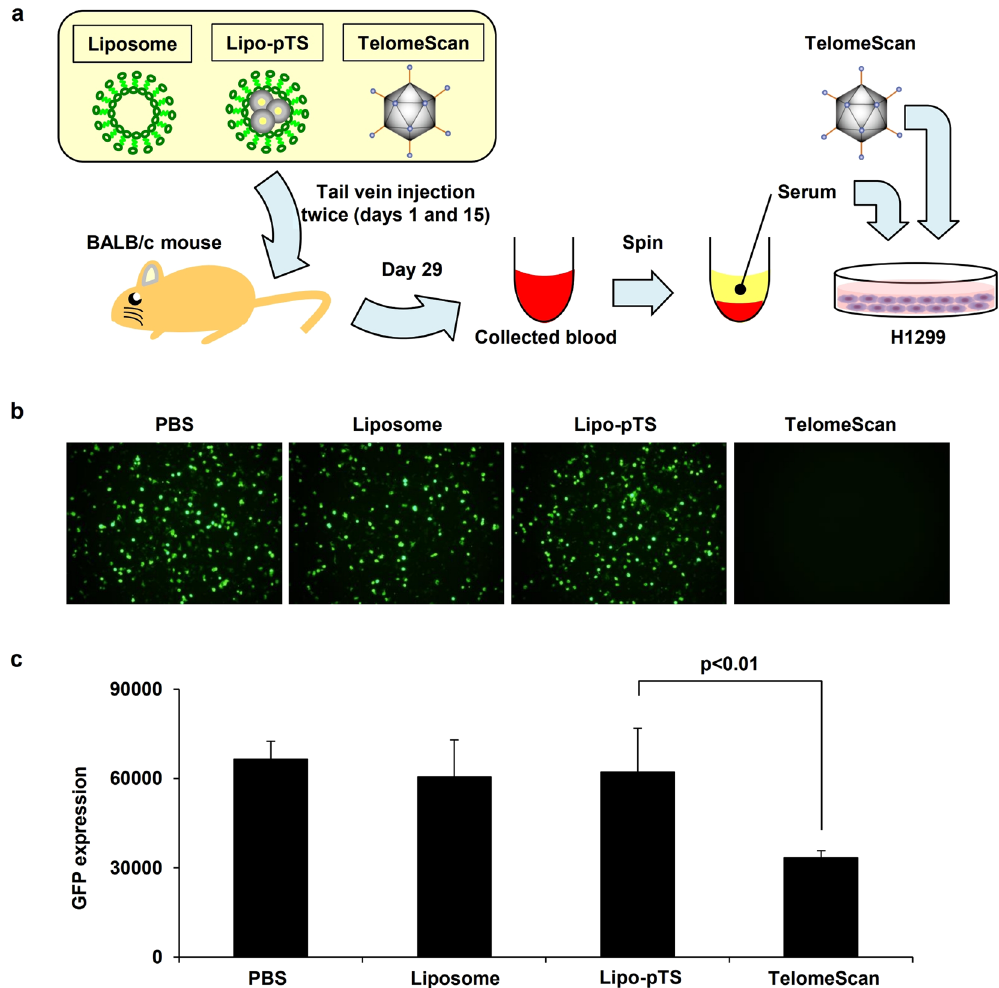
Figure 6. Stealth effect of Lipo-pTS providing protection from the immune system in vivo . ( a ) The graphic shows the steps of the experiment. Briefly, PBS, Liposome, Lipo-pTS, or TelomeScan is systemically injected into immune-competent BALB/c mice twice every 2 weeks (days 1 and 15), and blood is collected from each mouse at day 29. H1299 cells are treated with TelomeScan for 3 days in the presence of the serum collected from the mice. ( b ) After the steps described in ( a ), GFP spots are observed on fluorescence microscopy. ( c ) The intensity of GFP spots is measured by flow